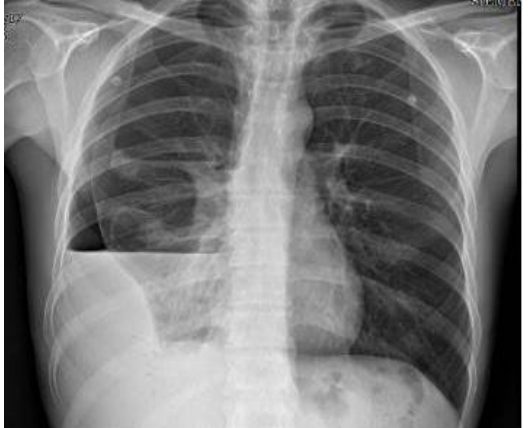
Figure 1. Chest X-ray which is diagnostic for right hydropneumothorax